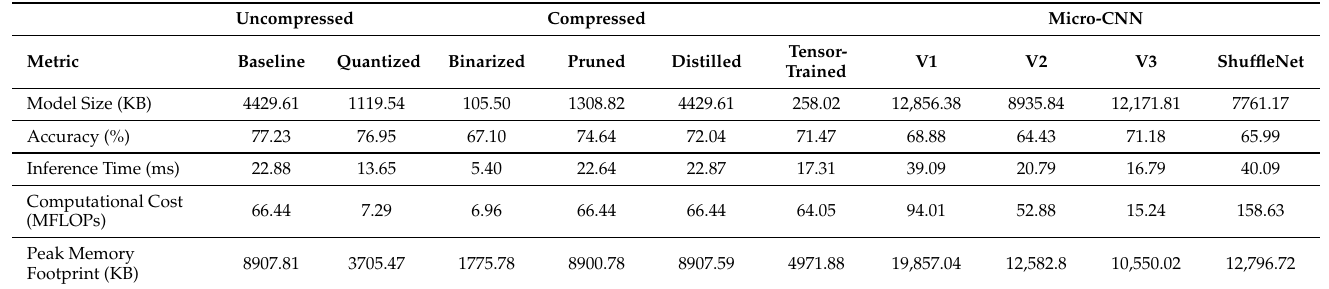
Table 2. Evaluation metrics results of the compressed models, base model, and micro-CNN